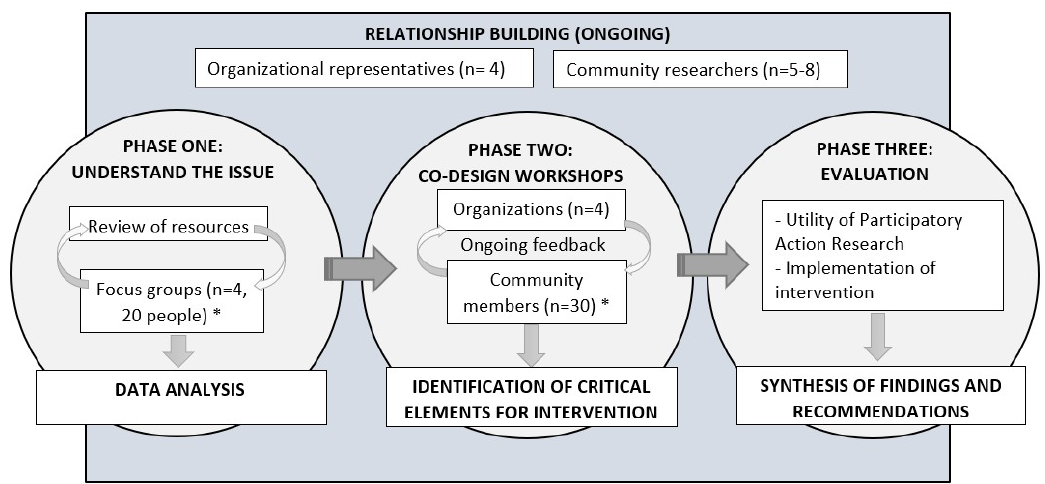
Figure 1. Project flowchart. Note: The above flowchart shows the minimum numbers required (indicated by *). Cycles of participatory action research will continue until it is felt that there is sufficient understanding to progress to next cycle.